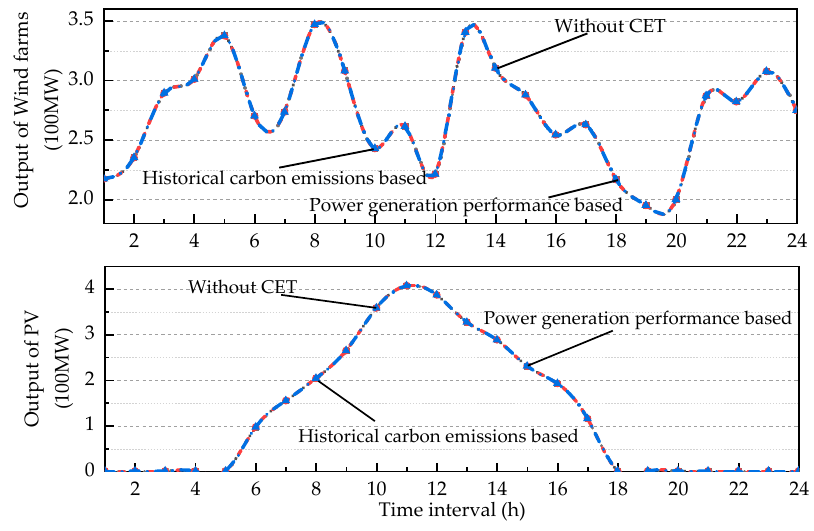
Figure 14. Comparison of outputs of renewable units.